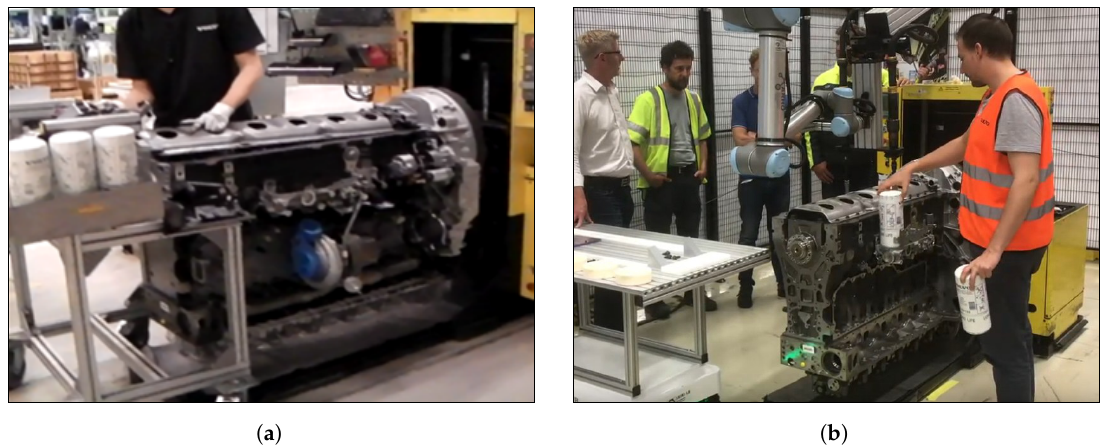
Figure 1. Transformation of a manual assembly station into a collaborative one: ( a ) the original manual assembly station; and ( b ) the collaborative robot assembly station controlled by a network of ROS2 nodes. A video clip from the demonstrator can be found at: https://youtu.be/TK1Mb38xiQ8 (accessed 11 March